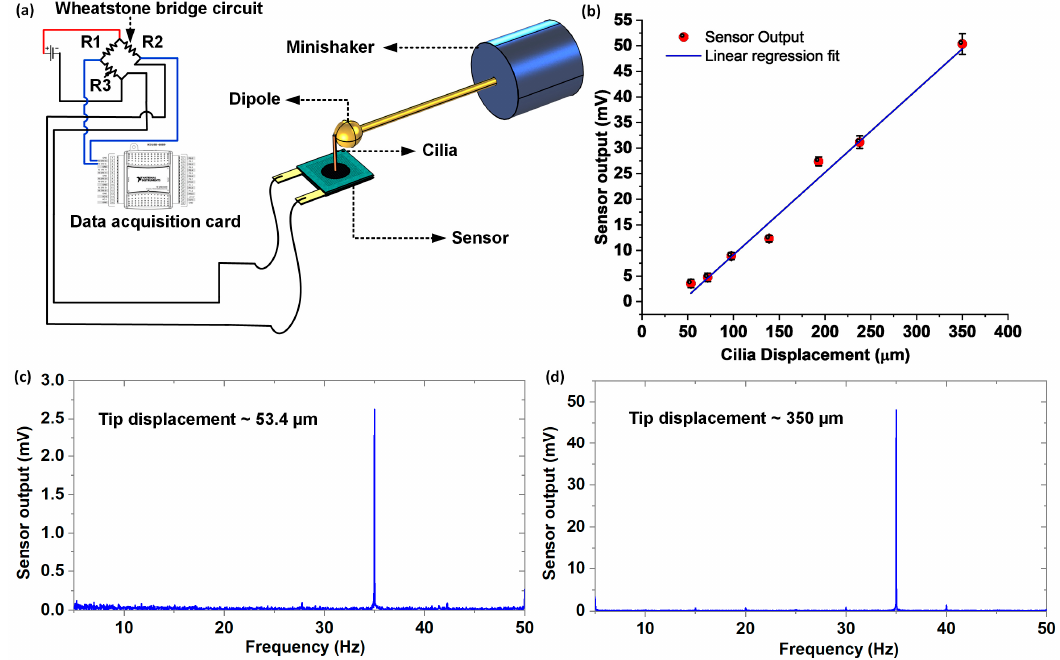
Figure 5. Tip displacement versus sensor response characterization: ( a ) Schematic representation of the experimental setup used for the test, to characterize the tip displacement response of the flow sensor; ( b ) Plot showing sensor output versus the cilium displacement; ( c , d ) FFT amplitude plot showing the sensor responses at 35 Hz for two different oscillatory amplitudes (53.4 and 350 µm). The flow sensor was characterized for steady-state wind flow sensing in the velocity range of 1.8–9.3 m/s. Figure 6a shows the schematic representation of the custom in-house built wind tunnel setup, employed for conducting the steady-state flow calibration experiments. At each of the individual velocity points, the wind tunnel was turned on and off five times in a periodic fashion, with each cycle having a duration of 60 seconds; the experiment was repeated thrice. The sensor response from the Wheatstone bridge circuit was recorded. The Wheatstone bridge outputs for individual flow velocities were acquired, and average peak heights of the steady-state response signals were determined using OriginPro data analysis software. The peak heights were averaged over the five on-off cycles (per experimental run), and standard deviations were calculated for all the individual velocity points over the three runs of the experiment. Figure 6b shows the superimposed plots of the raw Wheatstone bridge outputs acquired for three different velocities (1.8, 5.77, and 9.3 m/s). Figure 6c shows the voltage response of the sensor to steady-state flow velocities in the range of 1.8–9.3 m/s, with the error bars representing standard deviation. The steady-state response of the sensor was found to be linear, with a high sensitivity of 6.16 mV/(m s − 1 ).